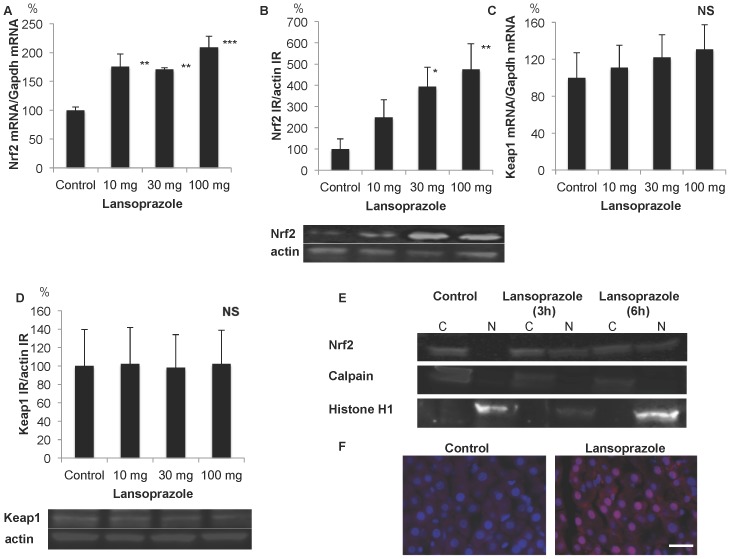
Up-regulation and nuclear translocation of Nrf2 in the liver following single oral treatment with lansoprazole.A) Up-regulation of Nrf2 mRNA in the liver at 3 h. ** P<0.01, ***P<0.001 compared with control. B) Up-regulation of Nrf2 immunoreactivity (IR) in the liver at 6 h. *P<0.05, ** P<0.01 compared with control. Representative photographs showing an increase of Nrf2 IR. C) No significant changes in Keap1 mRNA levels in the liver at 3 h. D) No significant changes in Keap1 IR levels in the liver at 6h. Representative photographs showing no change of Keap1 IR. E) Nuclear translocation of Nrf2 in the liver demonstrated by western blotting of cytosol fraction (C; Calpain-positive) and nuclear fraction (N; Histone H1-positive) at 3h and 6h. F) Nuclear translocation of Nrf2 in hepatocytes as demonstrated by double fluorescence immunohistochemistry. Blue indicates DAPI-positive nuclei, red indicates Nrf2 IR, and pink indicates the nuclear localization of Nrf2. Bar = 20 µm.